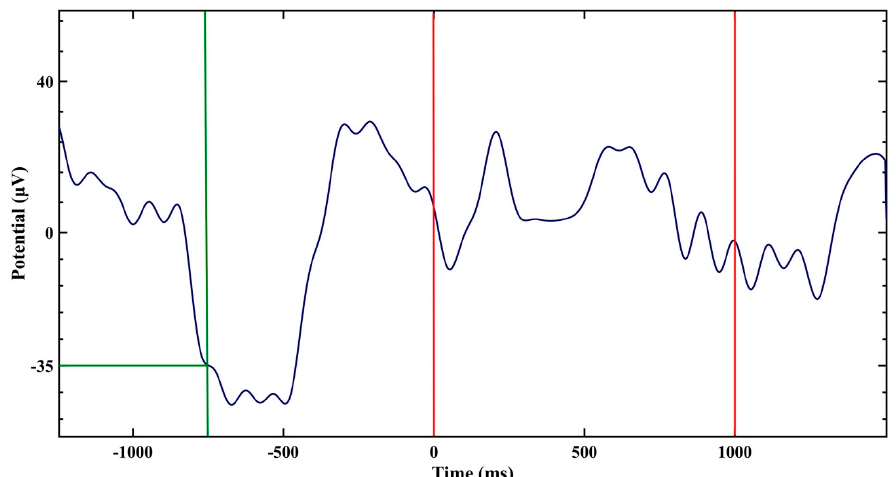
Figure 1. Schematic presentation of paired stimuli (red lines) programmed to start during stimulation epochs whenever the electroencephalography (EEG) wave crossed an established threshold ( − 35 µ V for representative study participant #9, green lines). After the crossing, the first stimulus (red line at “0” time) in this subject was set to be delivered in 0.5 s (but occurred in 0.75 s in fact, see Section 2 for an